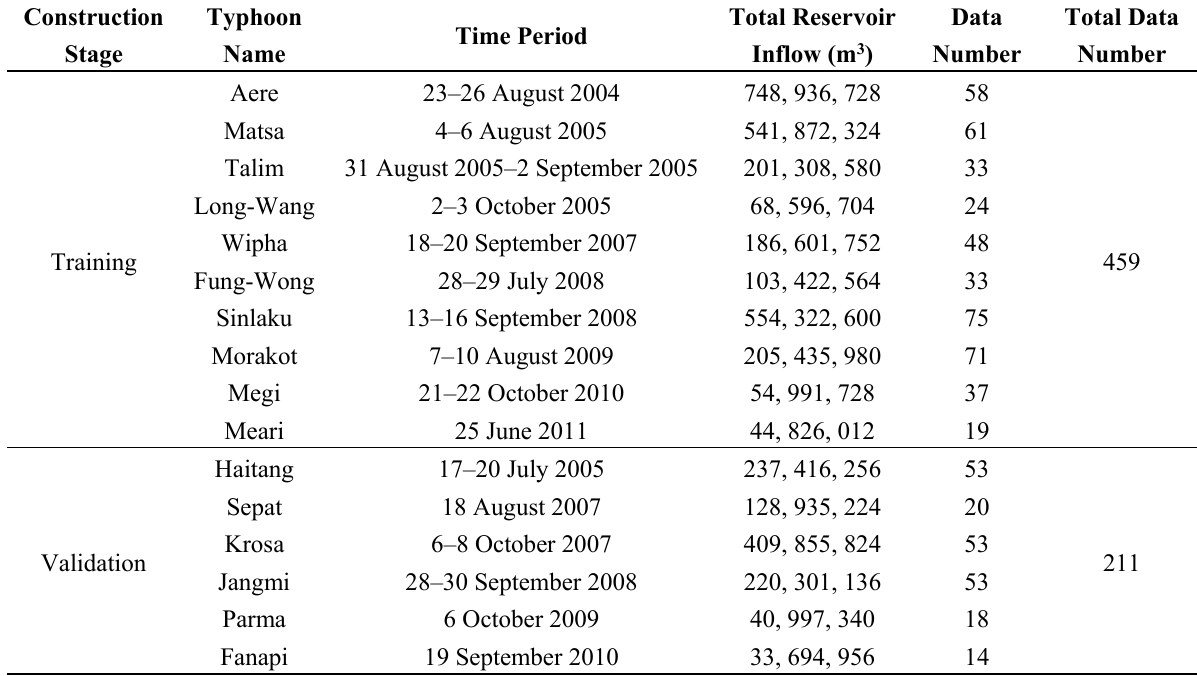
Table 1. The adopted typhoon events for model construction among the training and validation